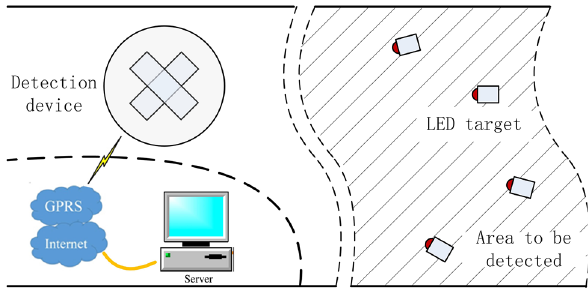
Fig. 2 Diagram of the relationship between the detected movement and the record on